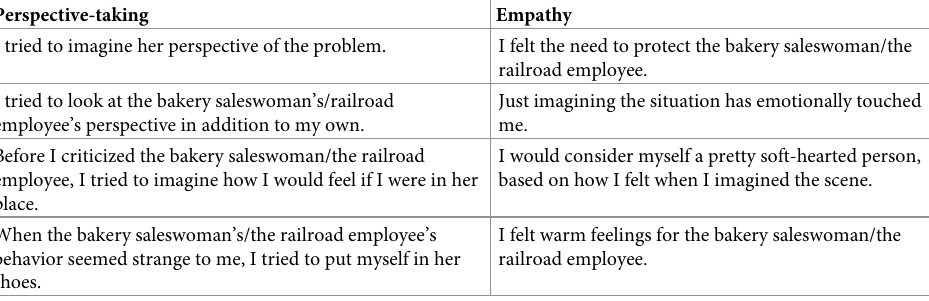
Table 1. Measurement of perspective-taking and